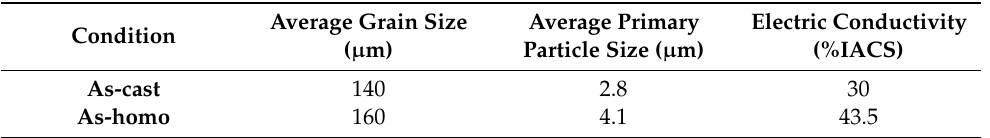
Figure 2. The typical microstructure of homogenized AA3003 aluminum alloy observed by ( a ) OM, ( b ) SEM-BEI, ( c ) TEM. Table 3. Change of grain size, primary particle size, and electrical conductivity in the DC cast AA3003 aluminum alloy by